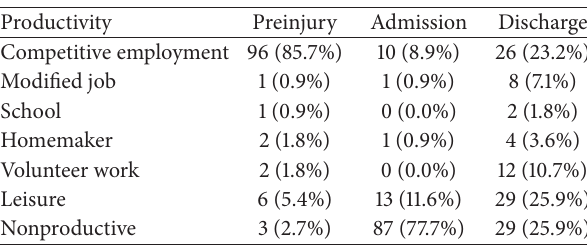
Table 4: Productivity of participants with hemorrhagic CVA.